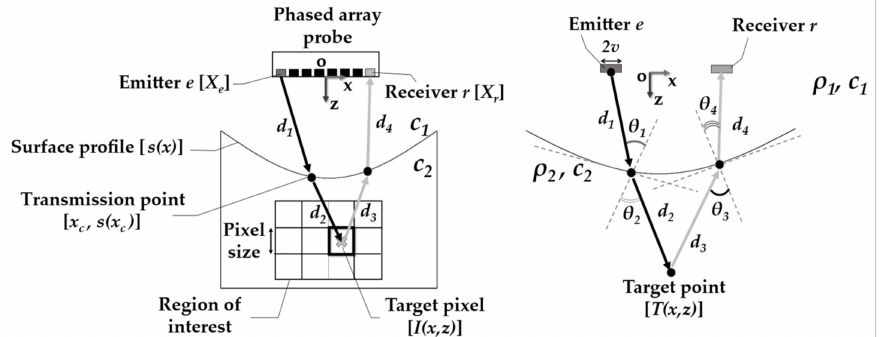
Figure 1. Schematic of the total focusing method applied to an immersed part with s ( x ) top surface profile. The waves travel from the emitter e to a pixel and then to the receiver r through the paths which respect the Fermat’s principle. The same applies for a point reflector T ( x , z ), where paths d have different refraction angles for each combination of e and r